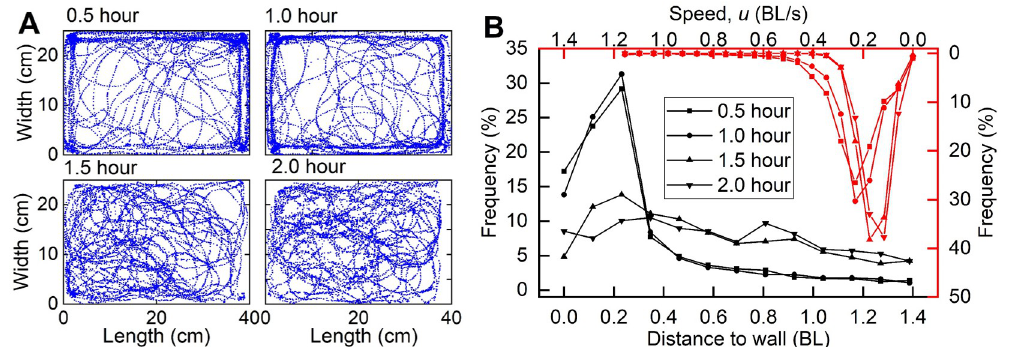
Fig 5. Fish behaviors. (A) Trajectory of S . rhinocerous projected into a horizontal plane during one trial for, 0–0.5 hour, 0.5– 1 hour, 1–1.5 hours, 1.5–2 hours from onset of experiment. (B) Frequency distributions of the distance to a wall (black line) and swimming speed (red line) for the same four time bins.